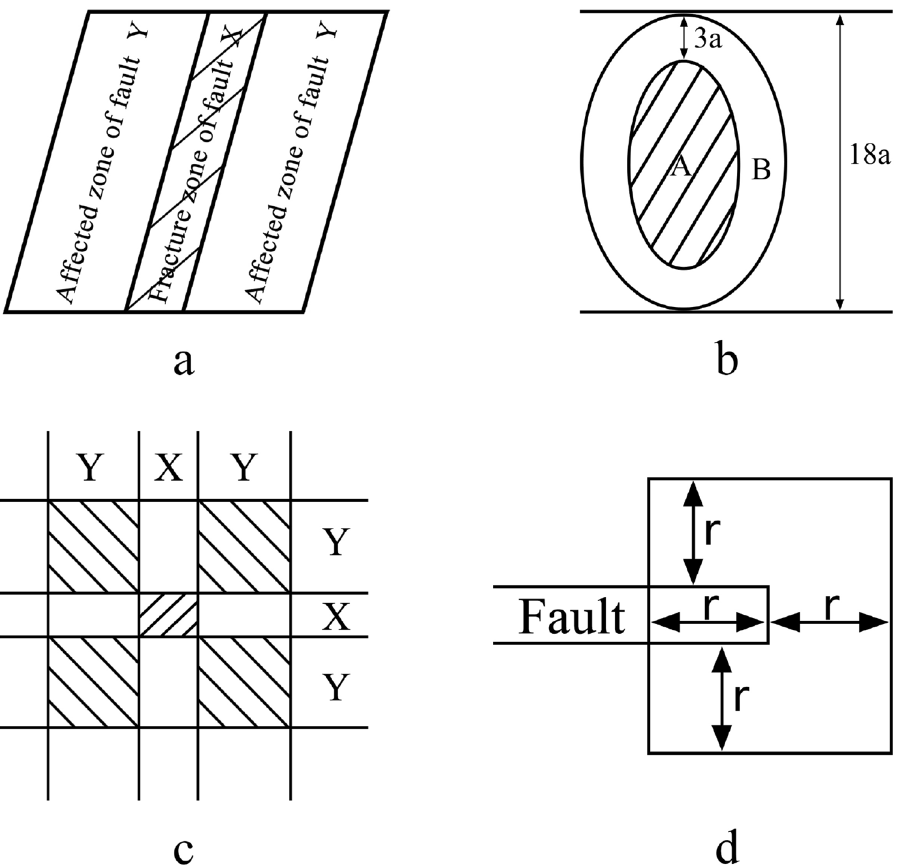
Figure 6. Schematic diagram of geotectonic assignment: ( a ) fault; ( b ) collapse column; ( c ) fault intersection; ( d ) fault